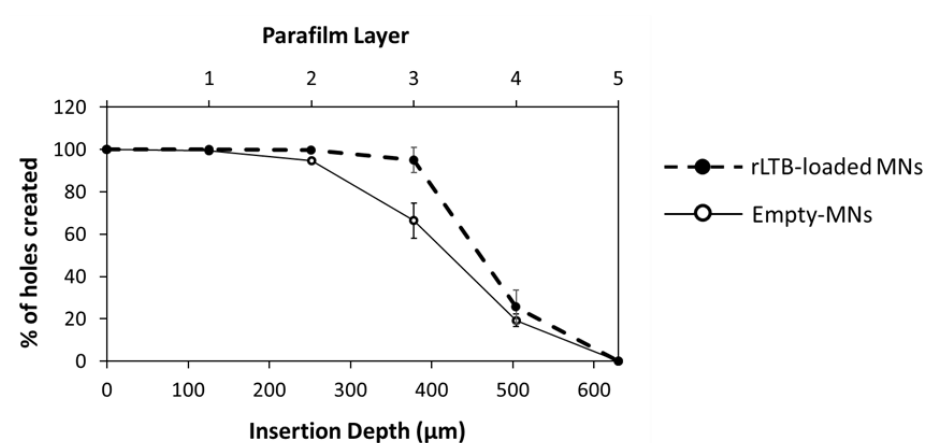
Figure 3. Percentage (%) of holes created by empty or rLTB-loaded Gantrez ® AN119 MN patches (MNs) in different Parafilm layers. Error bars represent S.D.